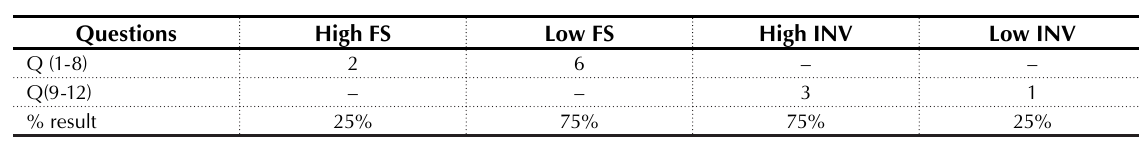
Table 6. Company (c)